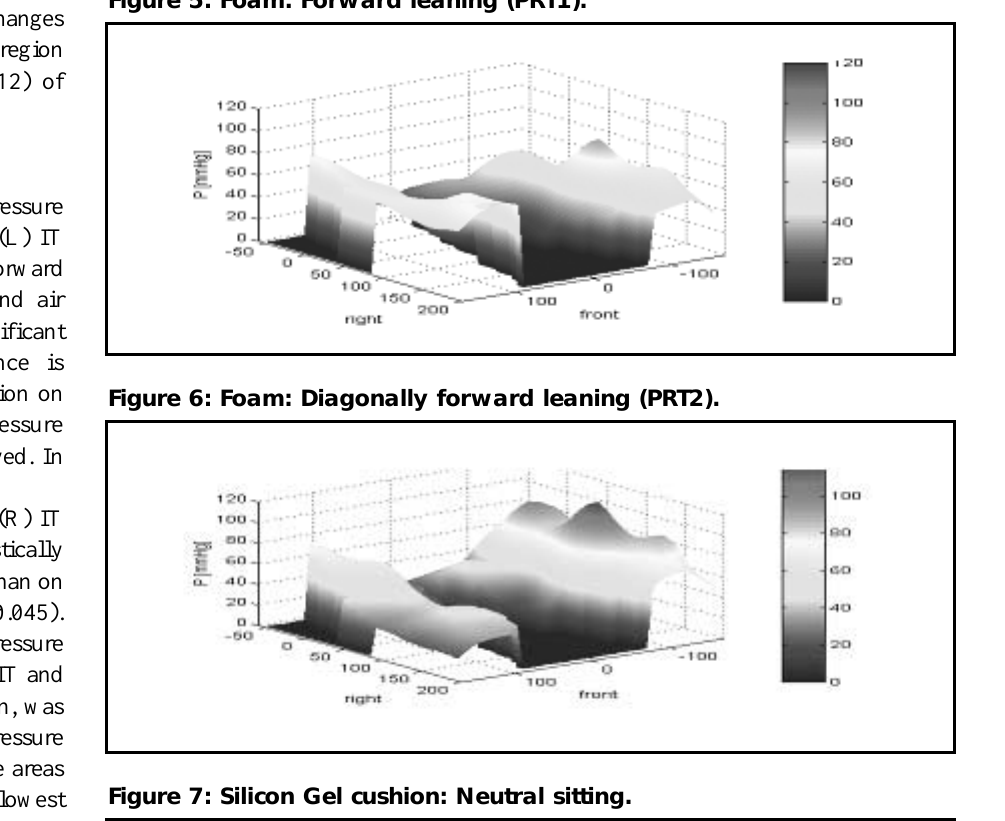
Figure 5: Foam: Forward leaning (PRT1).